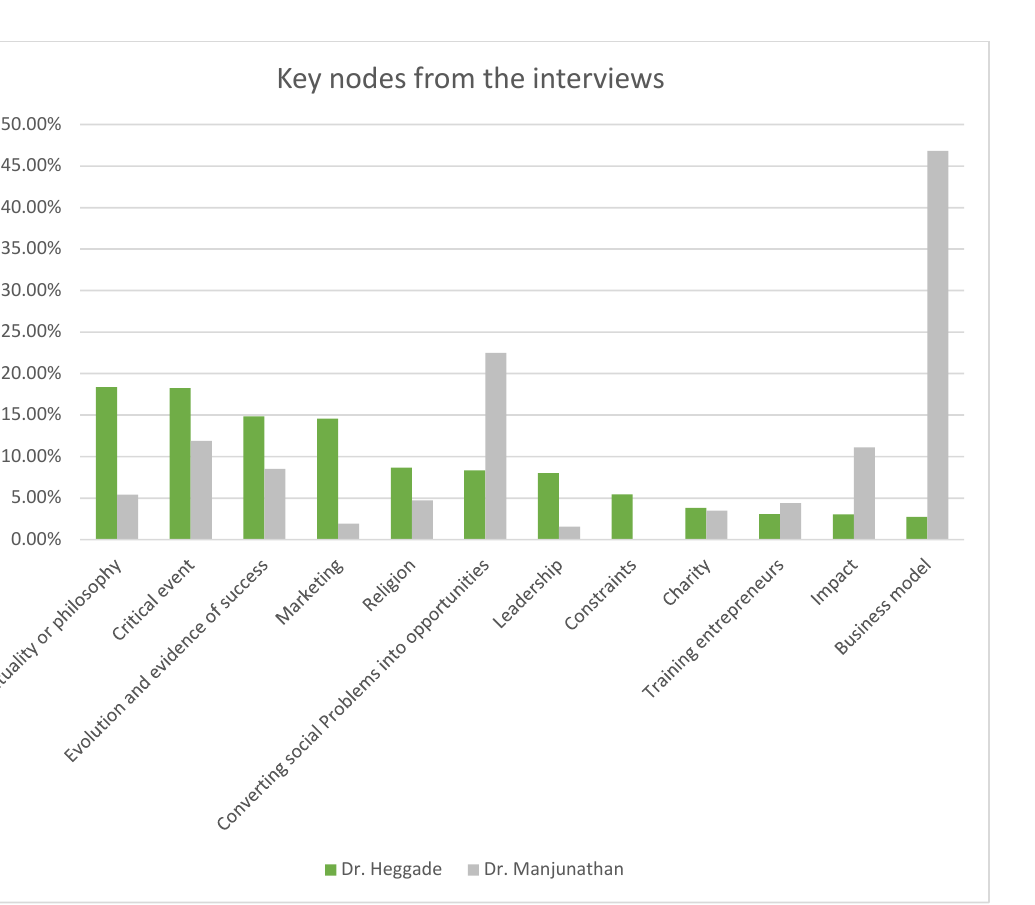
Figure 3. Thematizing the codes.